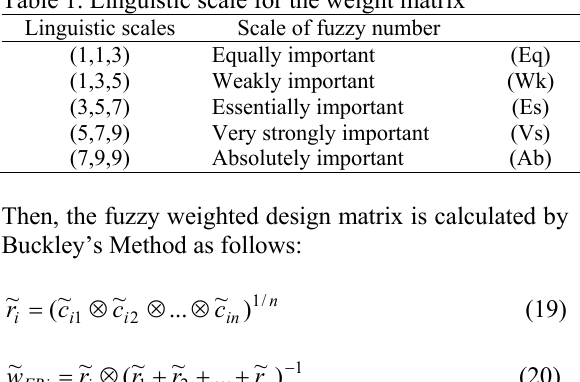
Table 1. Linguistic scale for the weight matrix